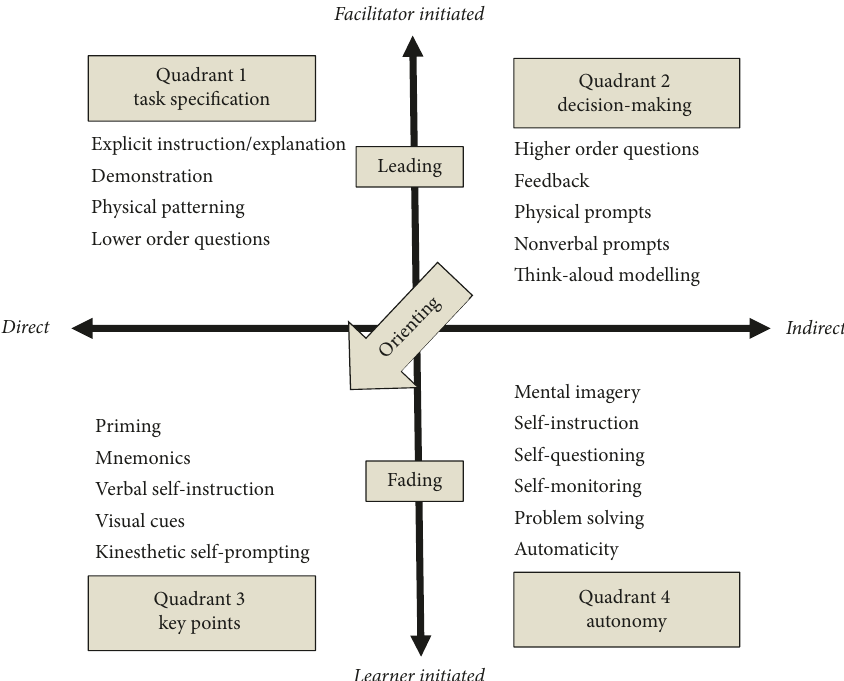
Figure 1: The Four-Quadrant Model of Facilitated Learning [modified from